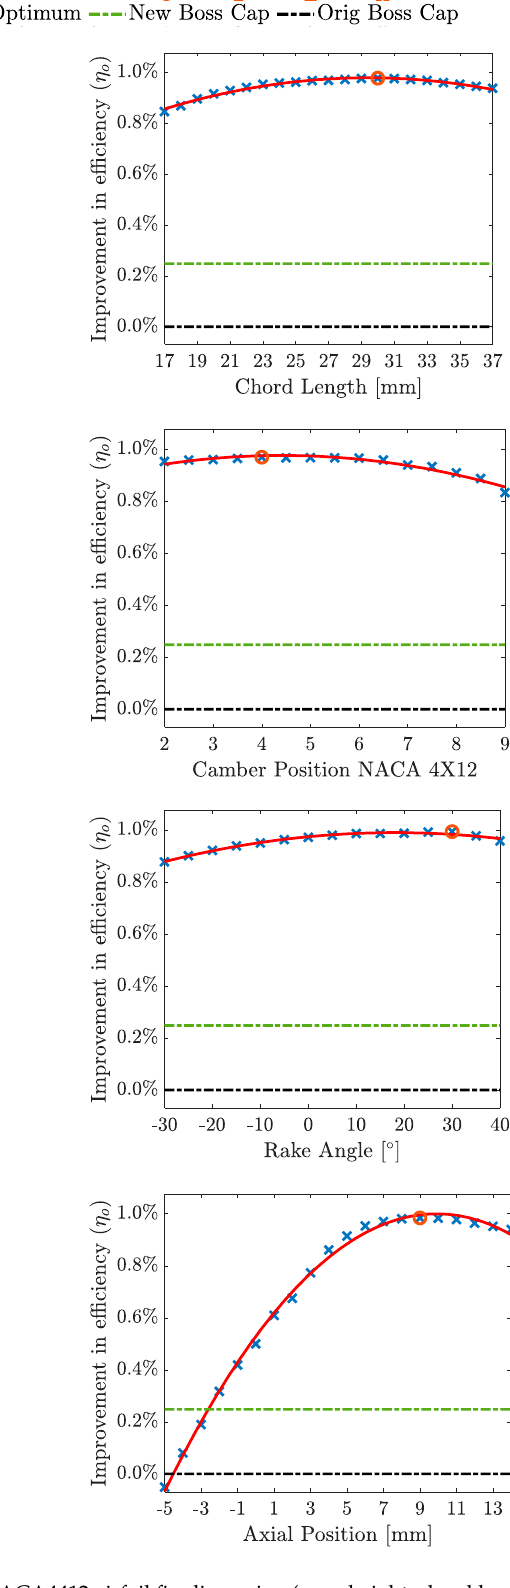
Figure 7. Effects of the overall NACA4412 airfoil fin dimension (span height, chord length), airfoil shape (maximum chamber X412 and its position 4X12, maximum thickness 44XX), and fin installation (rake angle, circumferential, and axial position) on the efficiency improvement of the propeller/rudder system.